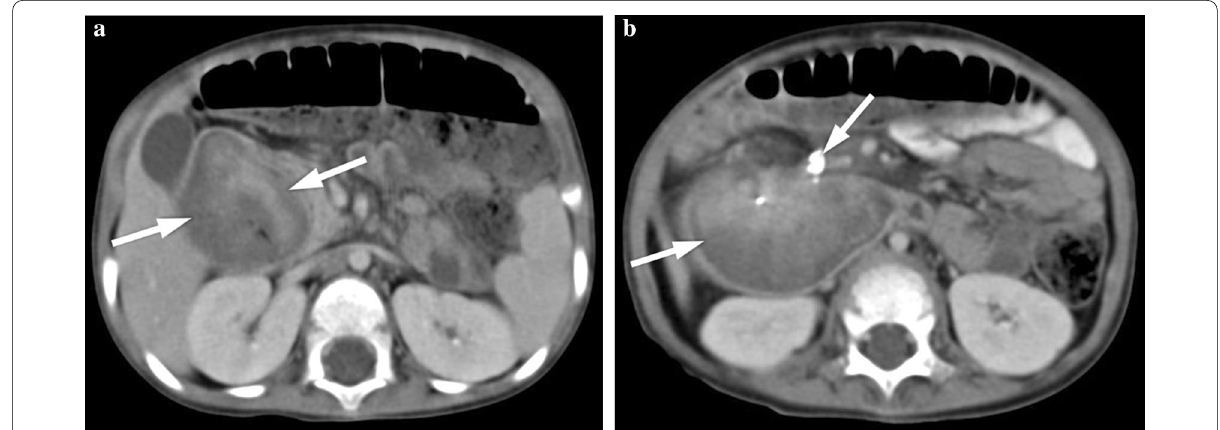
Fig. 13 a, b A 3-year-old boy with duodenal gastrointestinal stromal tumor who had been complaining of vomiting for 3 months. The mass was palpable in physical examination. a, b Contrast-enhanced axial CT images show duodenal tumor with calcifications (arrows)